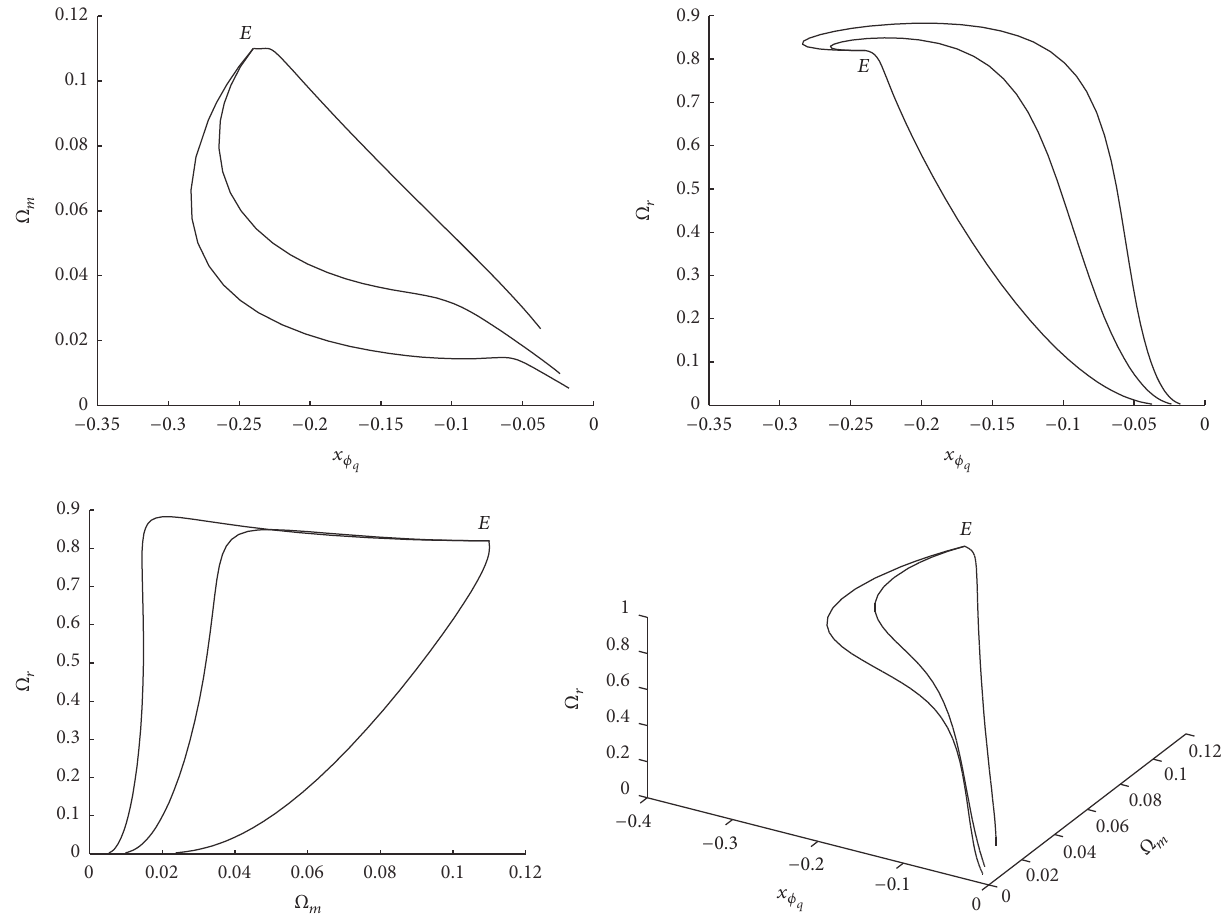
Figure 5: Two- and three-dimensional projections of the phase-space trajectories for 𝜆 = 1 , 𝛽 = 1.7 , 𝛽 = 2.6 , and 𝛽 = 3.5 . All plots begin from the critical point 𝐸 = (−0.24,0, 0.11,0.82) being an unstable solution.